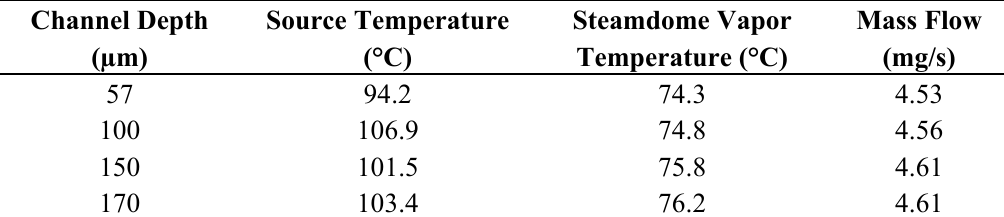
Table 1. Atmospheric boiler operation at 2.6 W thermal input.